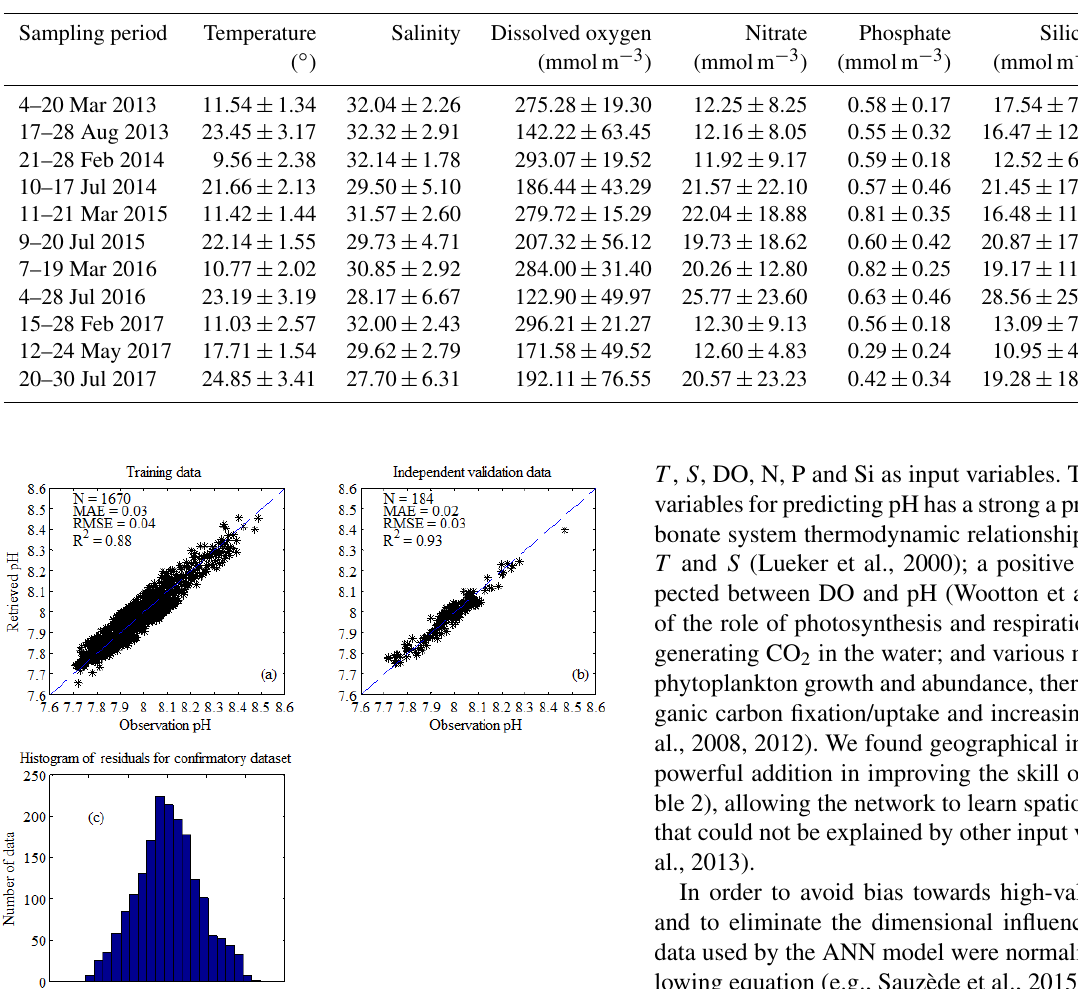
Table 1. Field survey information and measurements of water temperature, salinity, dissolved oxygen, nitrate, phosphate, silicate and pH T (mean ± SE).